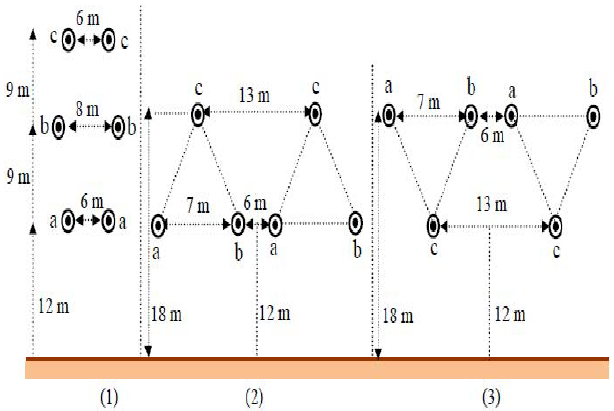
Figure 5: Different configurations of double circuit lines (1) Vertical, (2) Triangular (3), Inverted